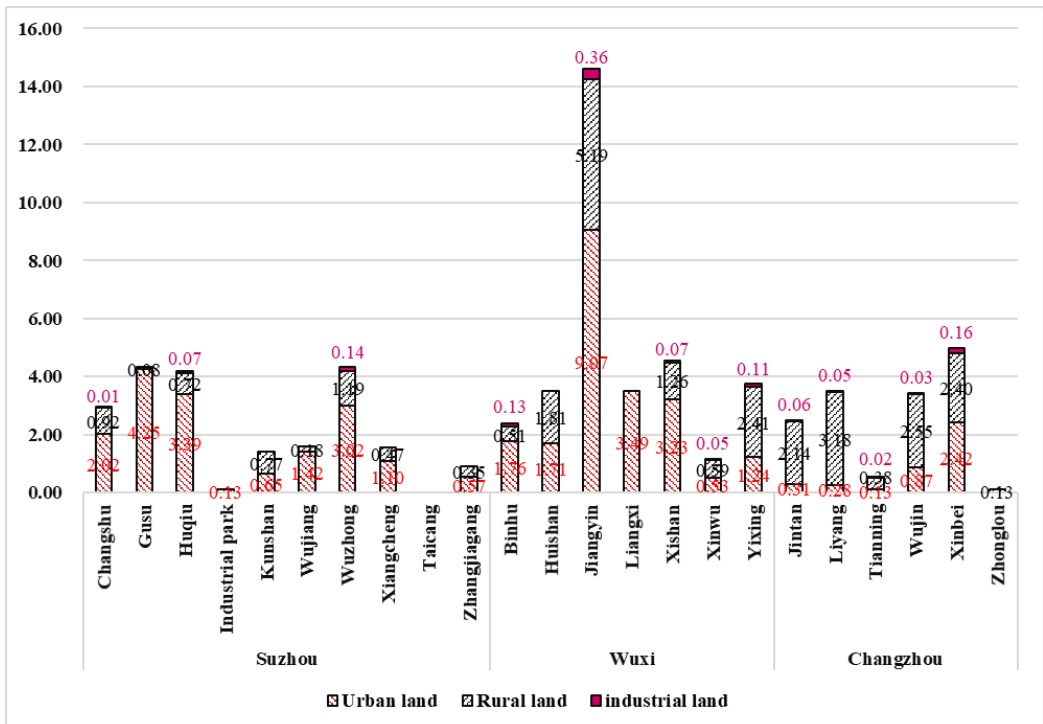
Figure 6. Amount of built land encroachments on GENs of each city and district (km 2 ).